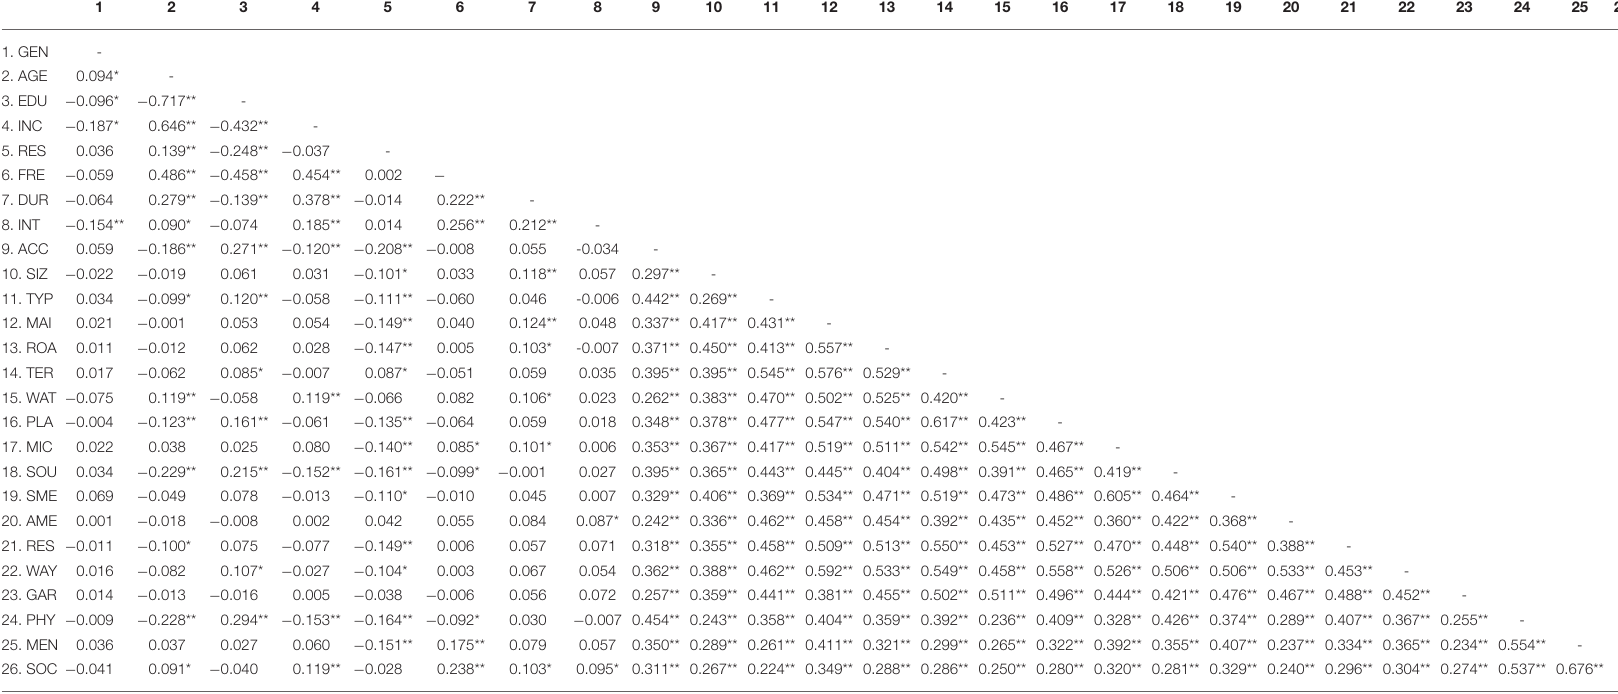
TABLE 4 | Correlation